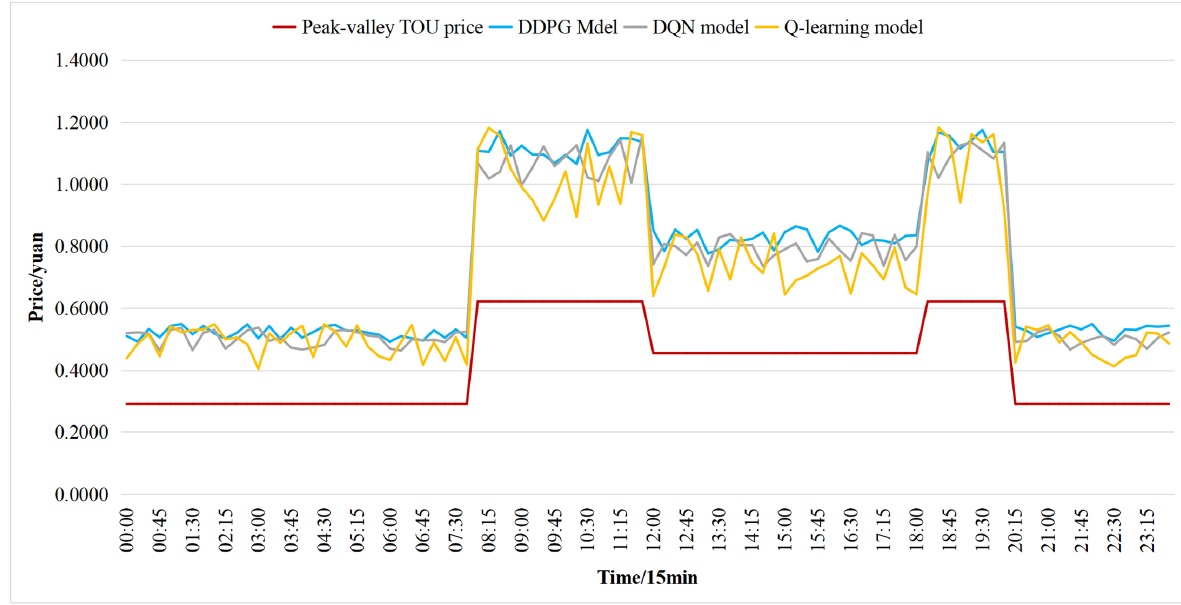
Figure 7. The retail price strategies based on different models. Table 3. The Comparison of Different DRL Models.